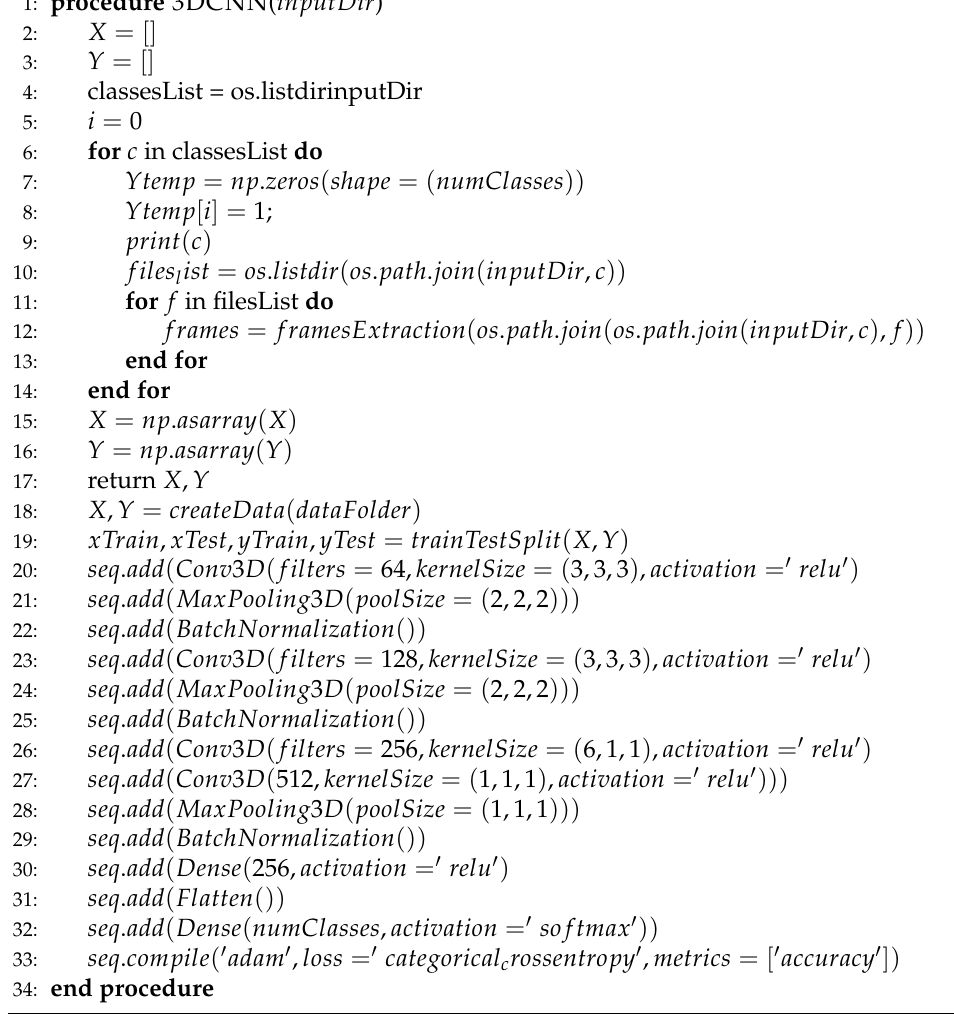
Algorithm 1 Pseudo-code of the proposed 3DCNN